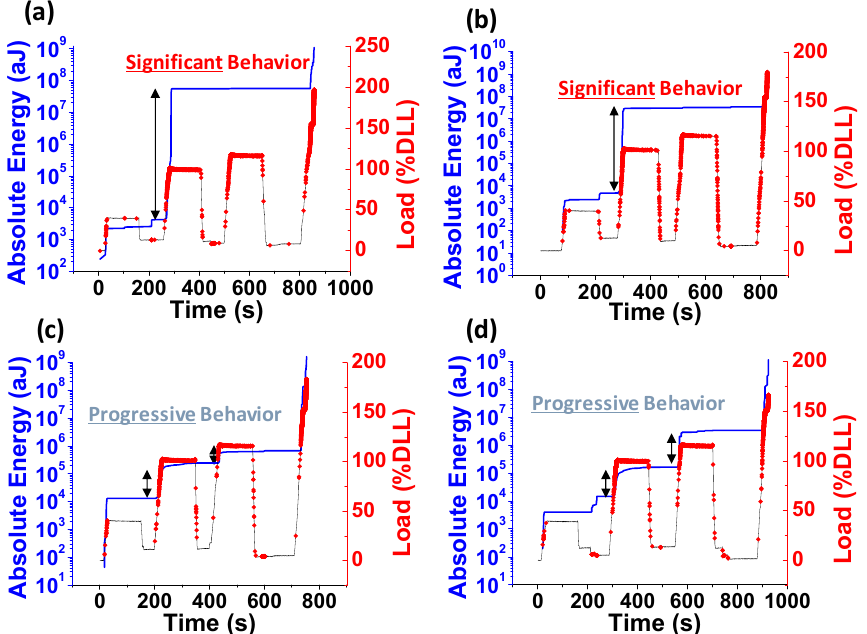
Figure 4. AE energy evolutions for the same tests shown in Figure 1. ( a ) Test 14, ( b ) Test 8, ( c ) Test 10, and ( d ) Test 4.